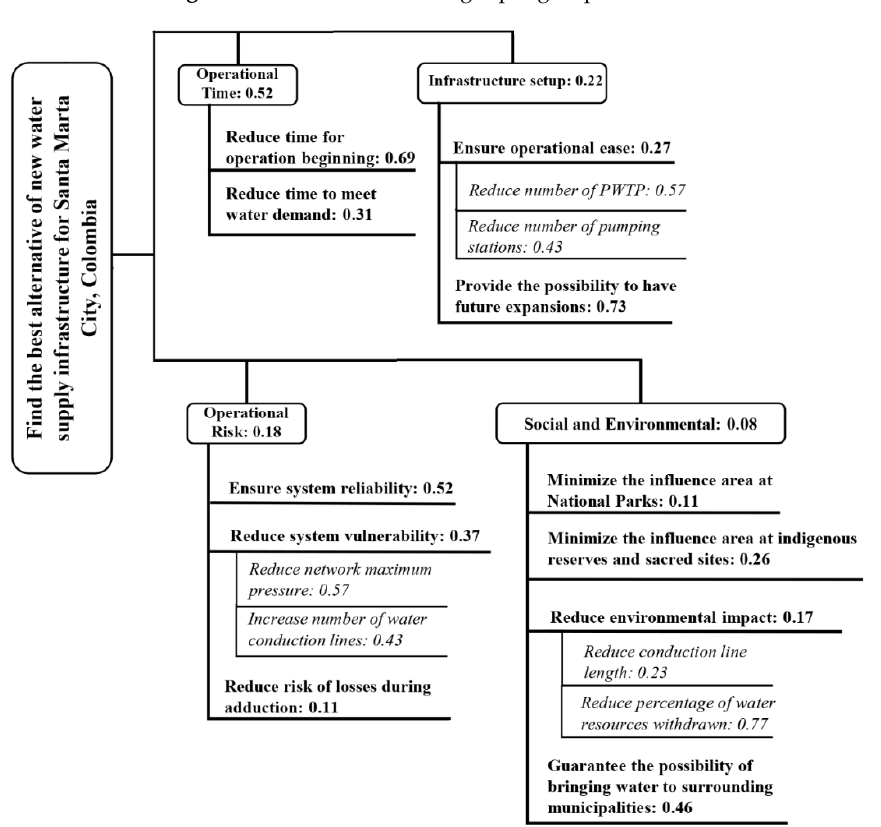
Figure 4. Hierarchical structure with relative weights.